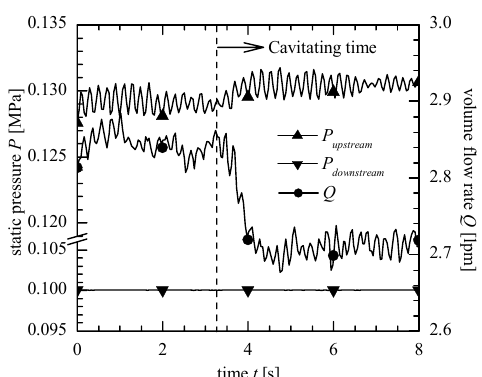
Fig. 5 Time evolution of the volumetric flow rate and the static pressure in the upstream and the downstream measured in the continuous cavitation type ( T = 75.8 K, Q = 2.85 lpm, σ = 0.71)